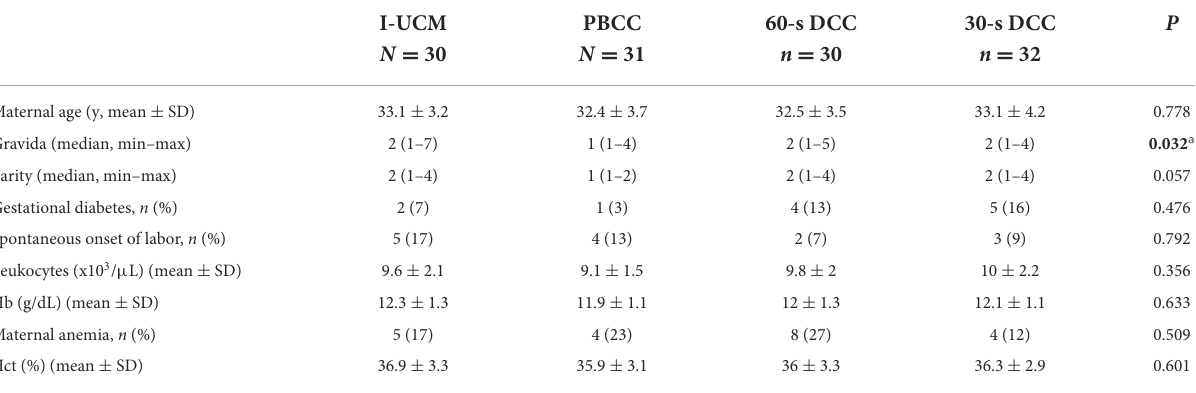
TABLE 2 Maternal demographic and laboratory data.